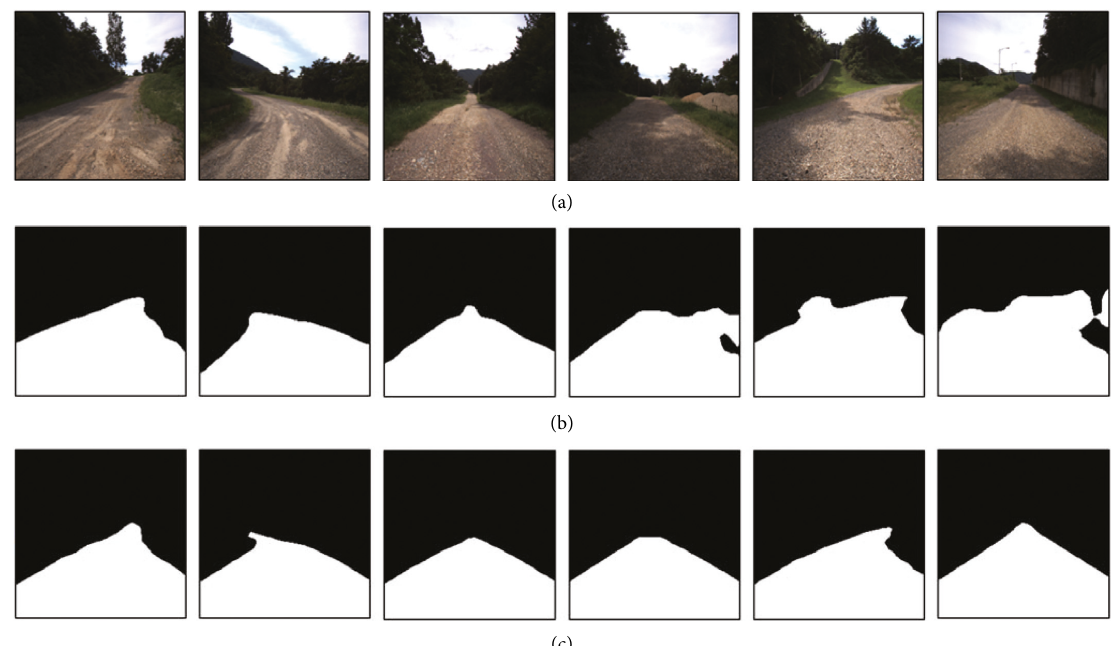
Figure 9: (a) Camera input image. (b) Inferenced segmentation results from the model trained with the ground-truth labels. (c) Seg- mentation results from the model trained with